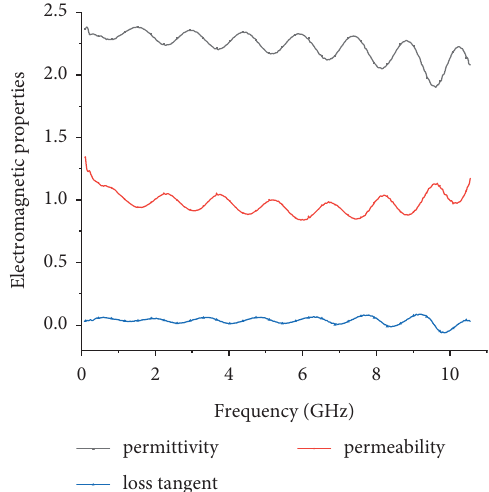
Figure 2: Measured permittivity and permeability.